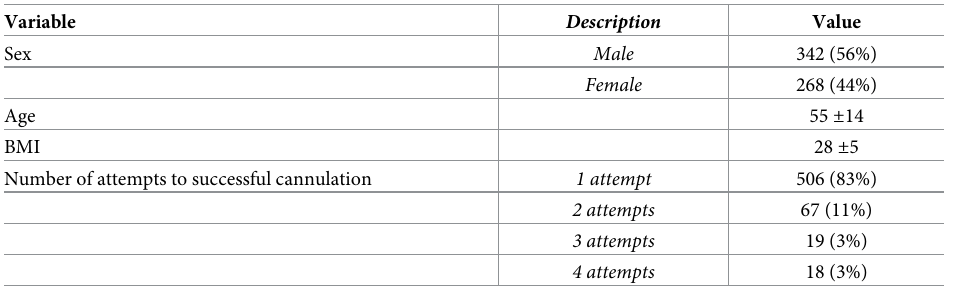
Table 1. Demographics of the included